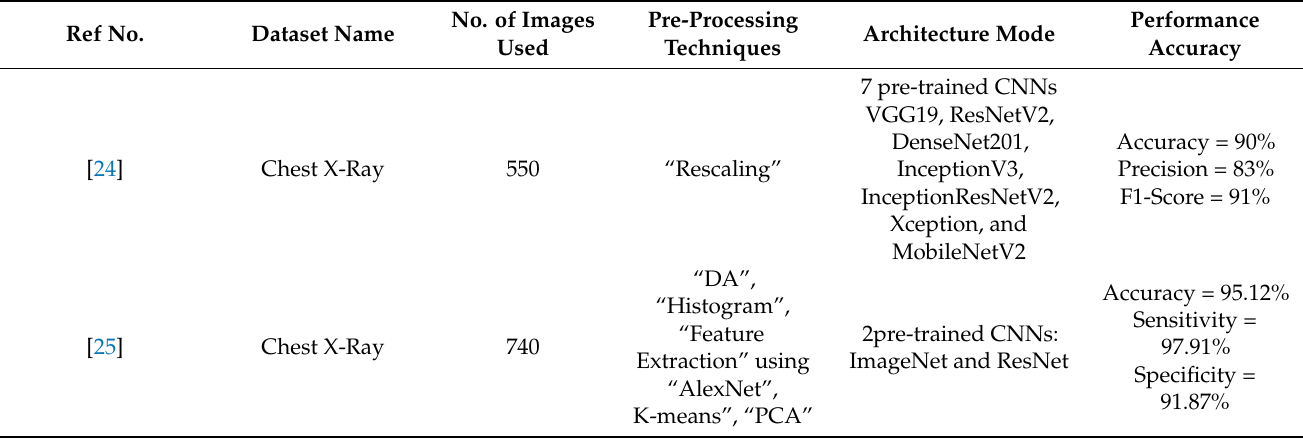
Table 1. Comparison of competitive recent related